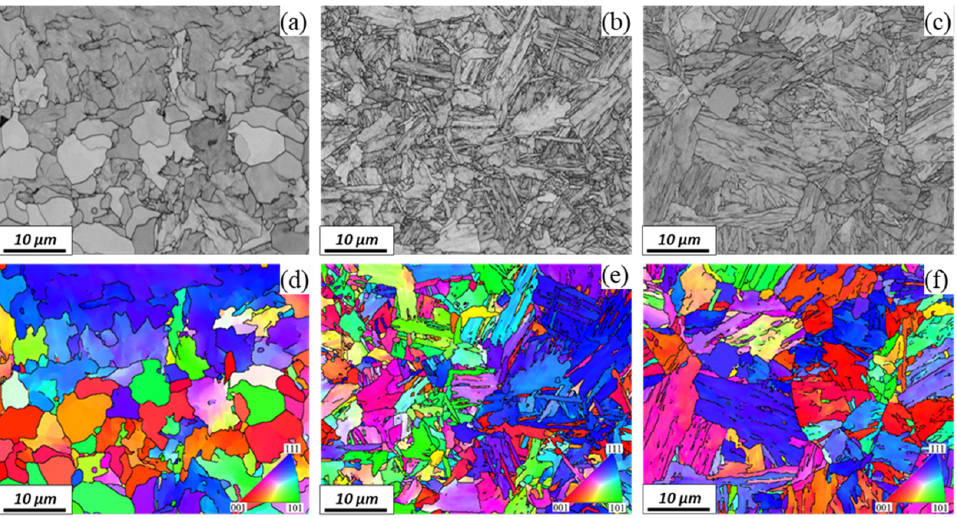
Figure 8. Band contrast and inverse-pole figure maps of ( a , d ) the as-received specimen, ( b , e ) specimen No. 2, and ( c , f ) specimen No.